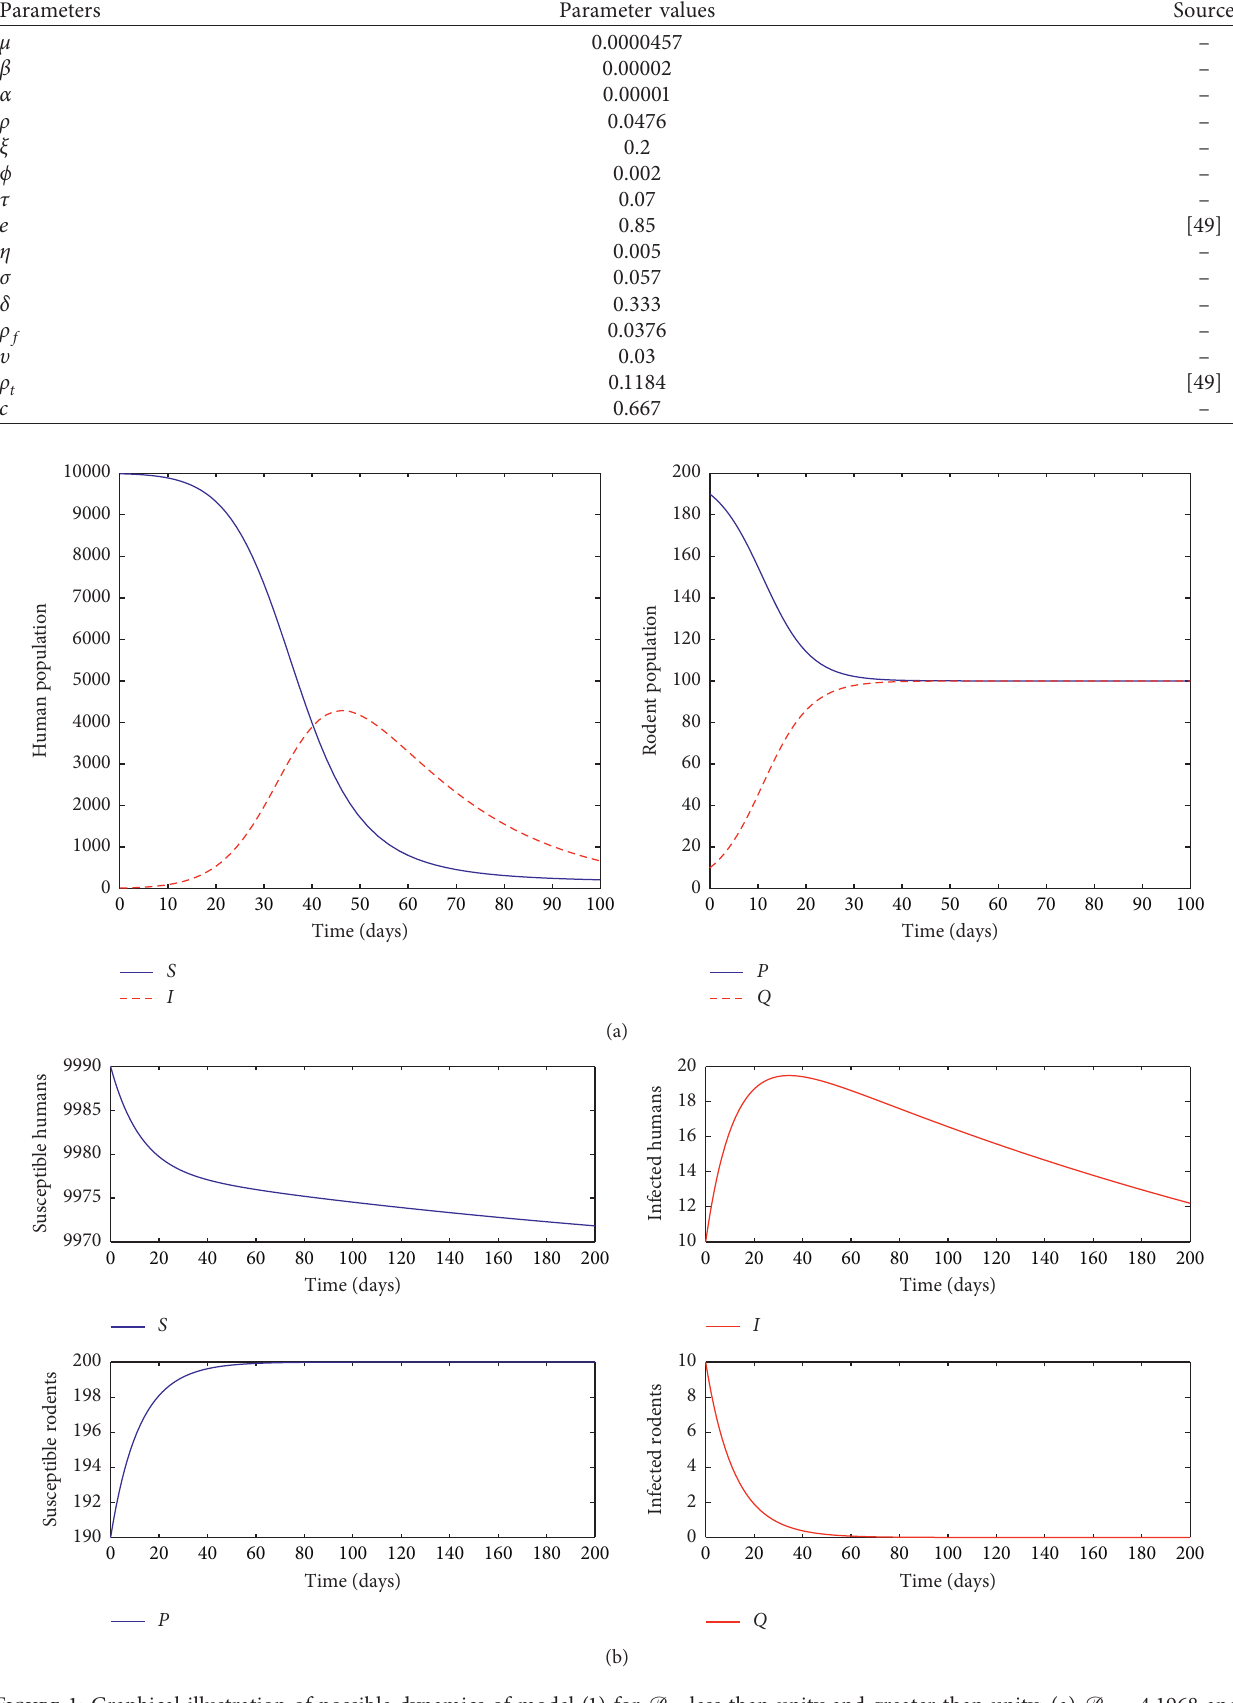
, less than unity and greater than unity: (a) R h � 4 . 1968 and 0